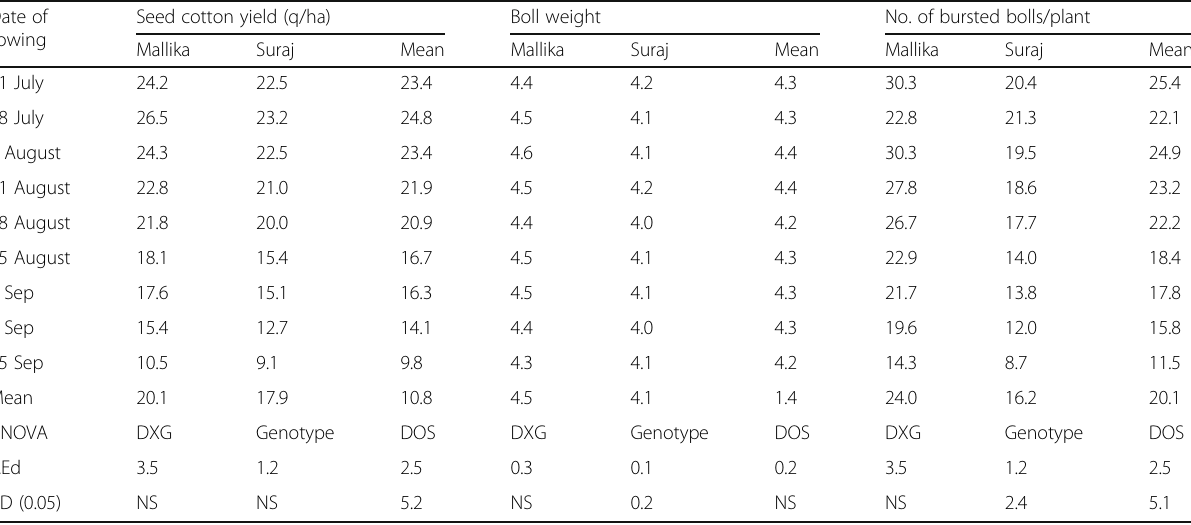
Table 4 Seed cotton yield (q/ha) and yield attributes as influenced by genotypes and date of sowing Date of